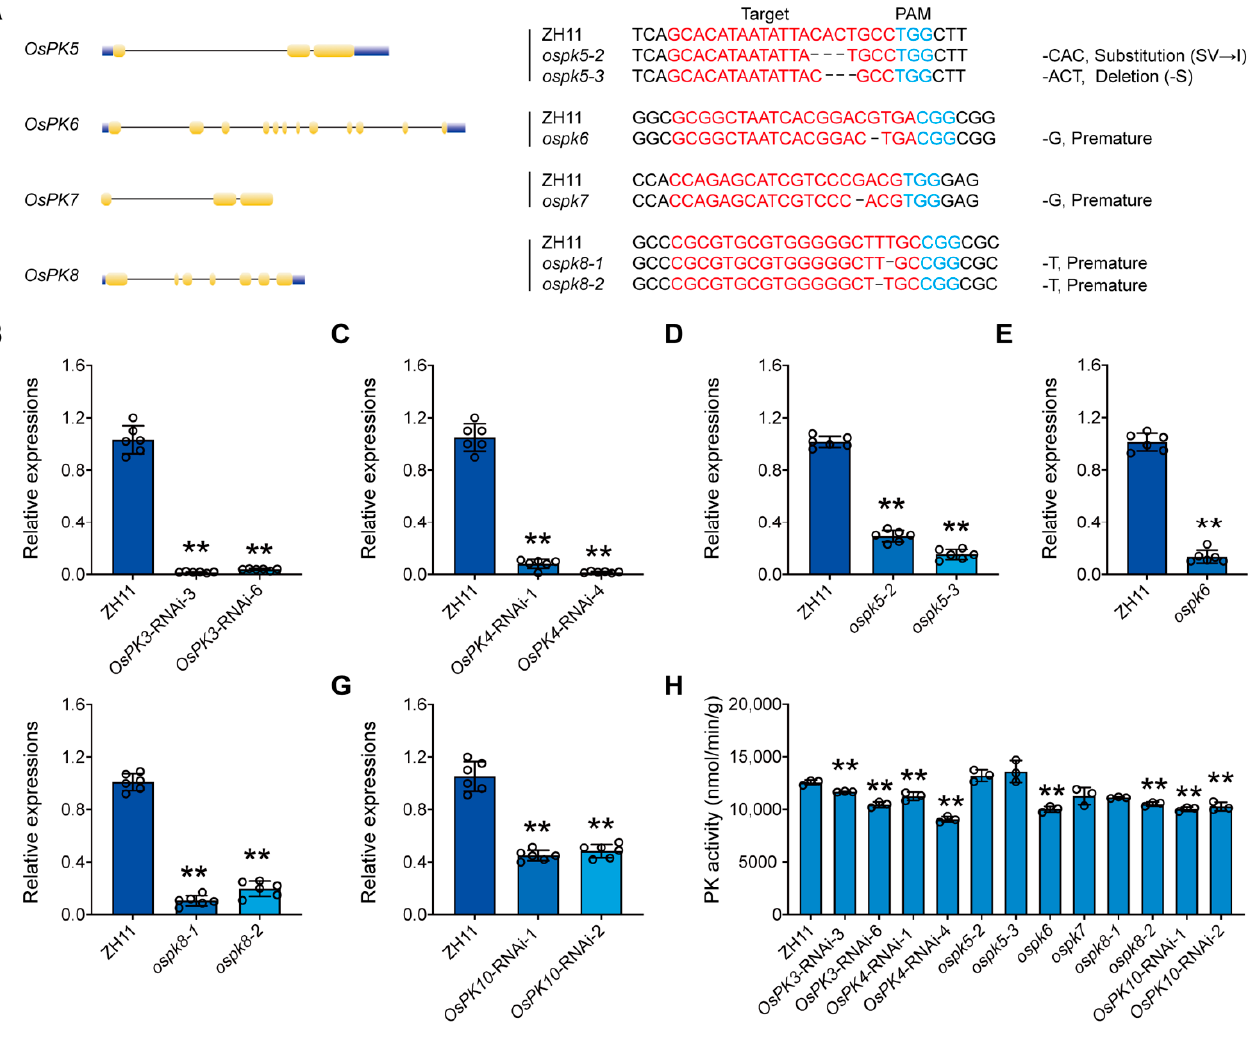
Figure 6. The acquisition of the CRISPR/Cas9-based mutants and RNAi lines of PK genes in rice. ( A ) The structure, PAM sequence, and editing of OsPK5 , OsPK6 , OsPK7 , and OsPK8 . ( B – G ) The relative expression of OsPK3, OsPK4, OsPK5, OsPK6, OsPK8 , and OsPK10 in the corresponding lines. ( H ) Pyruvate kinase activity of grains ten days after flowering. Error bars indicate the means ± SDs of six individual replicates. Asterisks indicate statistical significance between the WT and the CRISPR mutants or RNAi lines, as determined by Student’s t -test (** p < 0.01).